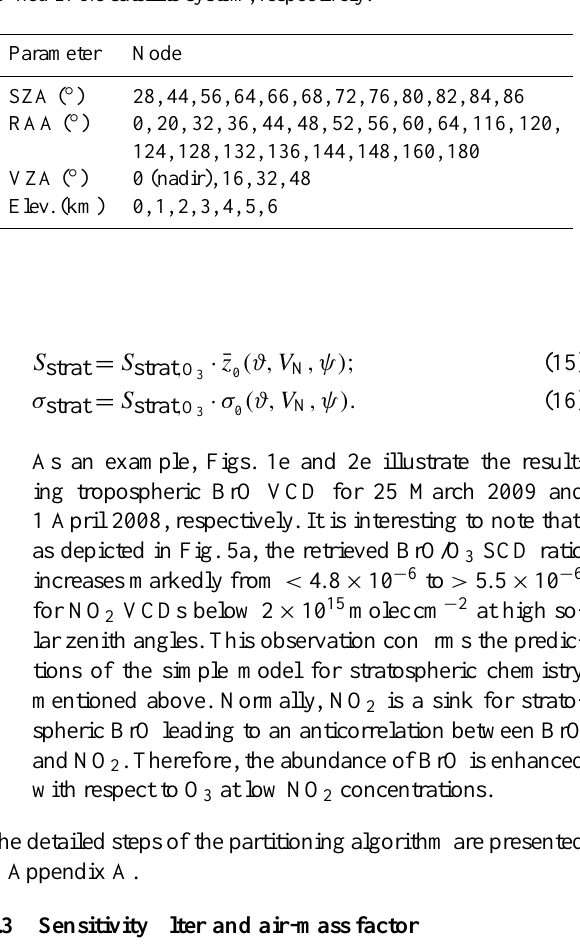
Table 3. Modelled layers of scattering media (aerosols and/or clouds) defined by their lower and upper edge over ground and the optical density